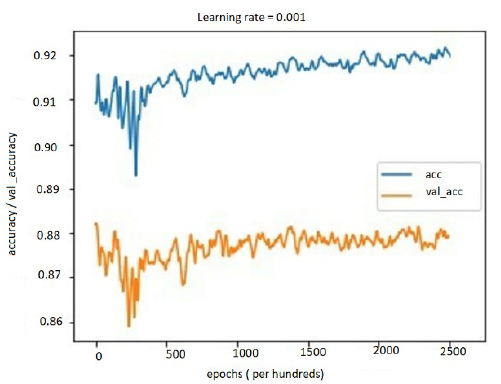
Figure 18. Training accuracy/validation accuracy versus epochs for the multimodal system.